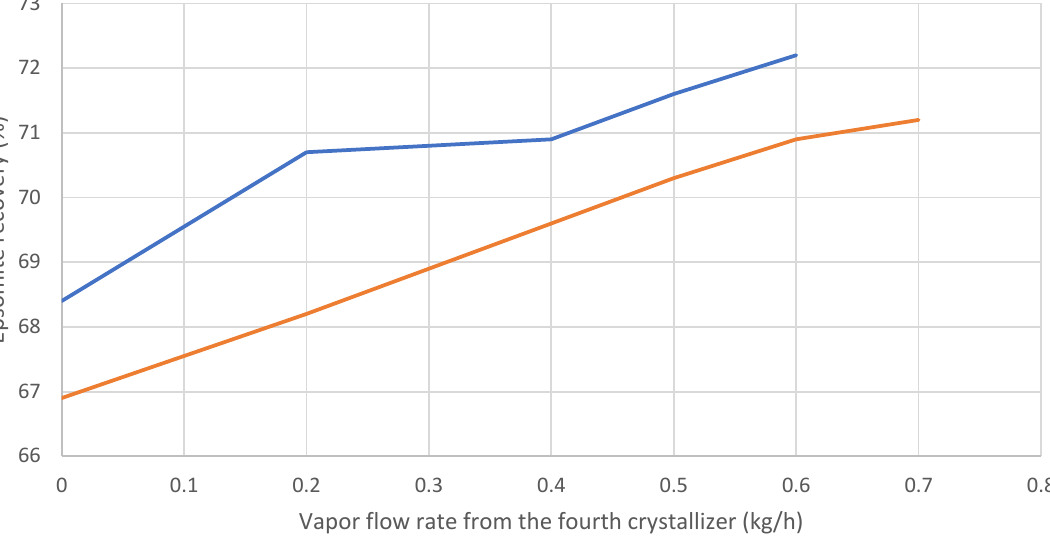
Figure 4. Evolution of the recovery of epsomite from the fourth crystallizer as a function of vapor flow rate at 25 °C and 29 °C.